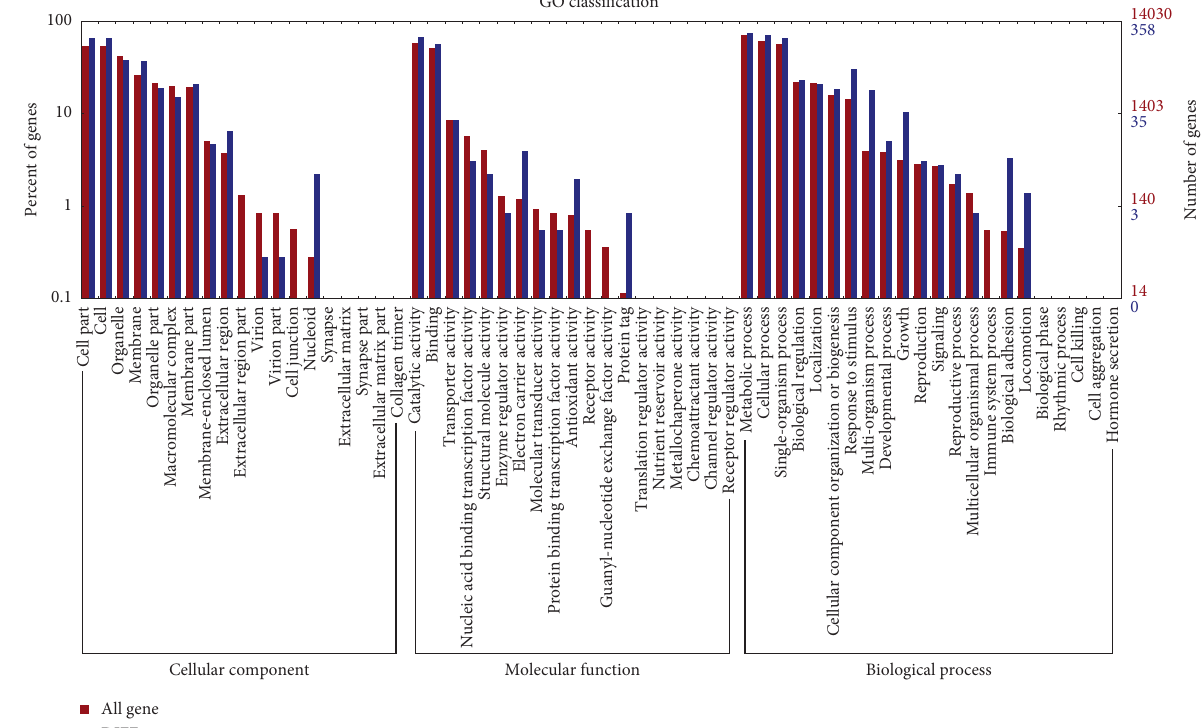
Figure 4: GO categorization of differentially expressed genes in P. expansum.